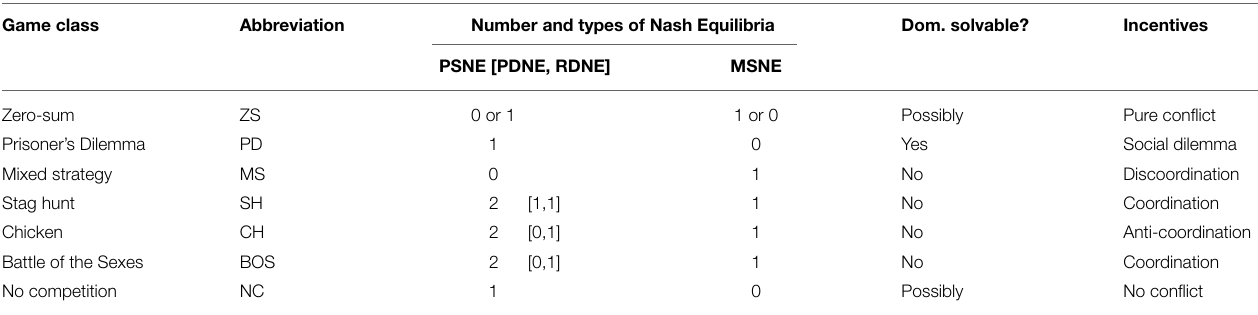
TABLE 1 | Game class